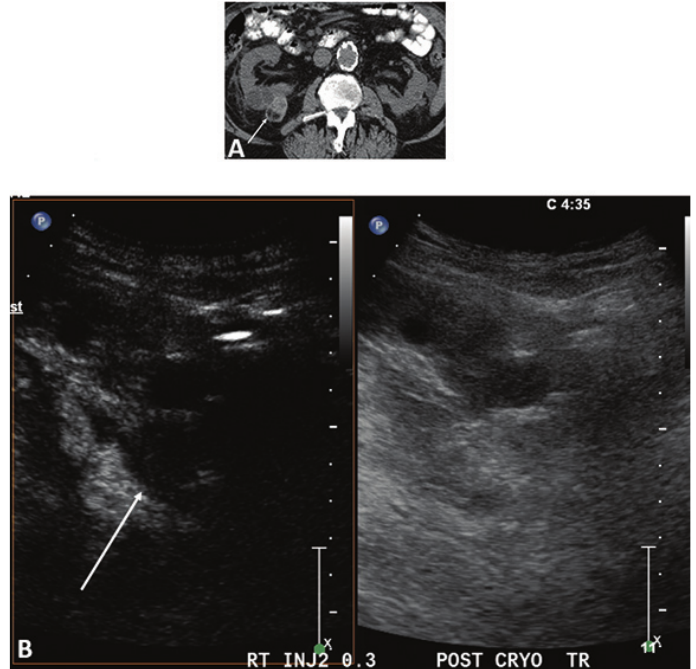
Figure 6. Images 6 months post-RFA of an RCC. (A) CT scan without contrast in this patient with renal failure. The ablated RCC (arrows) has significant attenuation making it difficult to determine if there is residual tumor. Even if contrast is adminis- tered, the background tissue makes it difficult to identify small areas of enhancement. (B) CEUS scan at the same 6-month post- RFA time point as the CT in (A). Ultrasound contrast agents can be used in patients with renal failure. Note that the excellent tissue suppression of CEUS allows for a contrast-only image, making it easy to see that there is no enhancement and no residual or recurrent